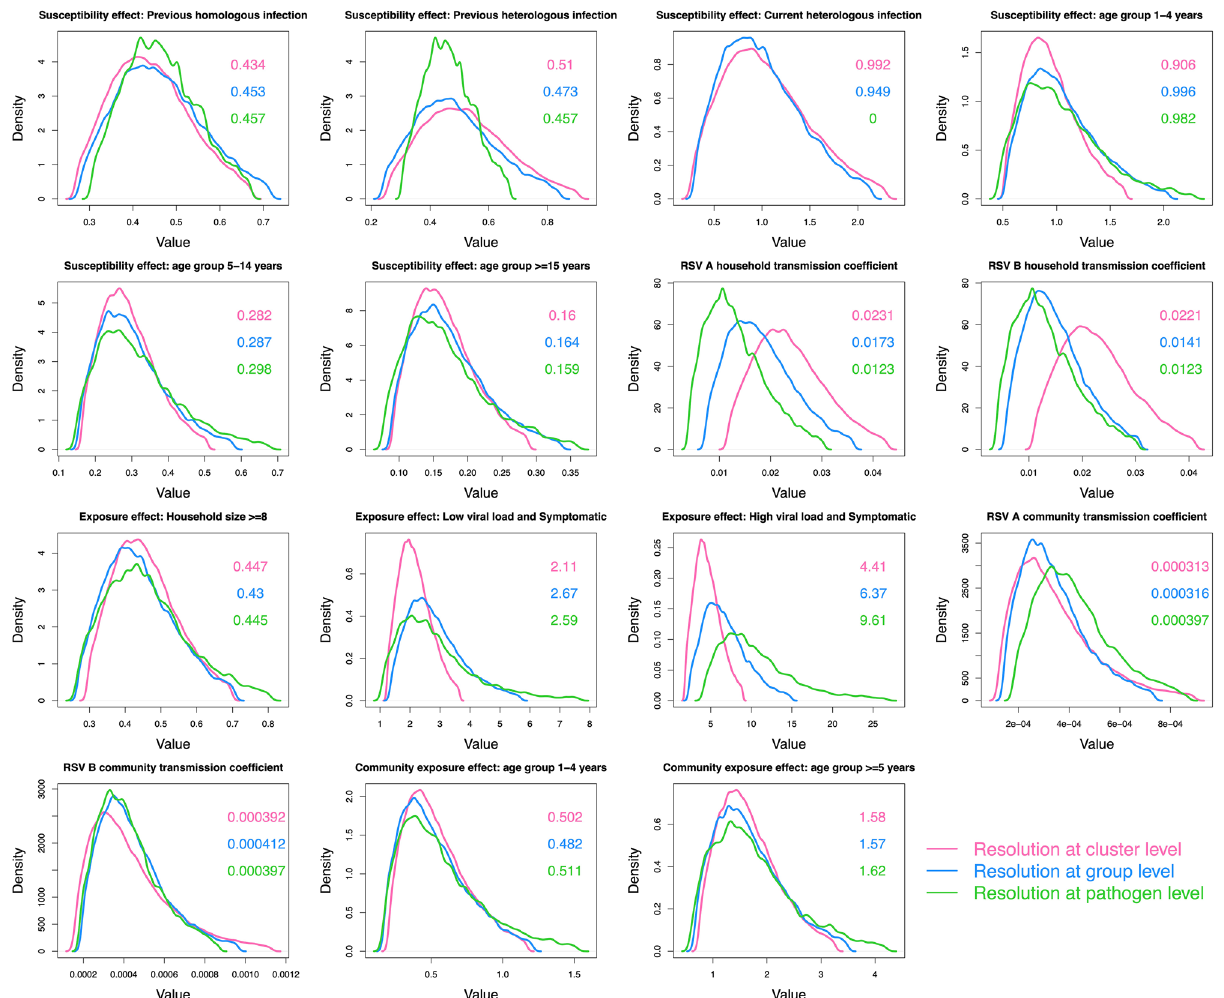
Figure 2. A comparison of the parameter distributions obtained from the model using different resolutions in pathogen identification. The green curves show the results using data at the pathogen level, the blue curves show the group level and the pink curves show the cluster level. Each panel shows 1 of 15 comparable parameters. The values in the panel are the median parameter estimates colour-coded by pathogen resolution. This figure was generated using